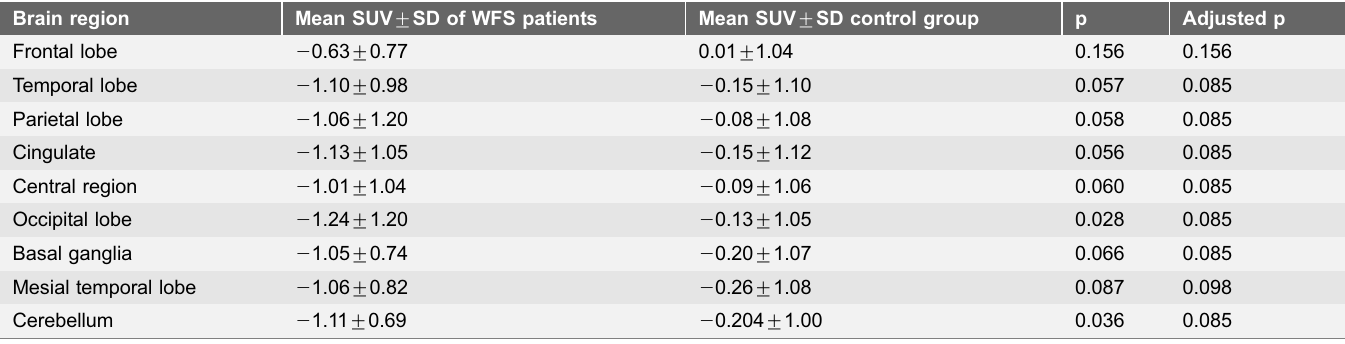
Table 3. Differences in mean SUVs for selected main brain regions between WFS patients. Brain